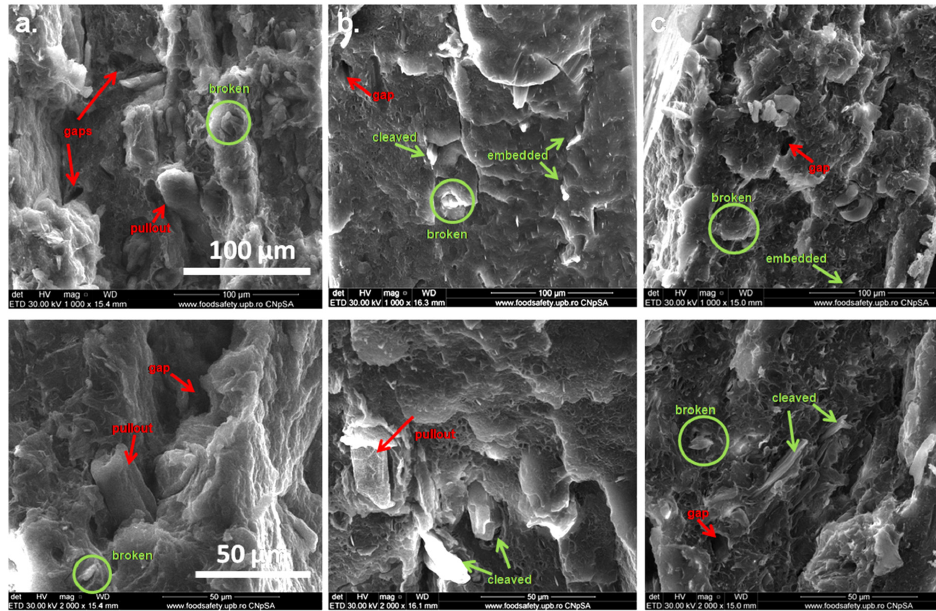
Figure 9. SEM images of PHB composites with di ff erent treated MCC: untreated MCC (( a ); × 1000, Figure 9. images of PHB composites with different treated MCC: untreated MCC (( a ); ×1000, ×2000); × 2000); MCC-T (( b ); × 1000, × 2000); MCC-P (( c ); × 1000, × MCC ‐ T (( b ); ×1000, ×2000); MCC ‐ P (( c ); ×1000, ×2000).